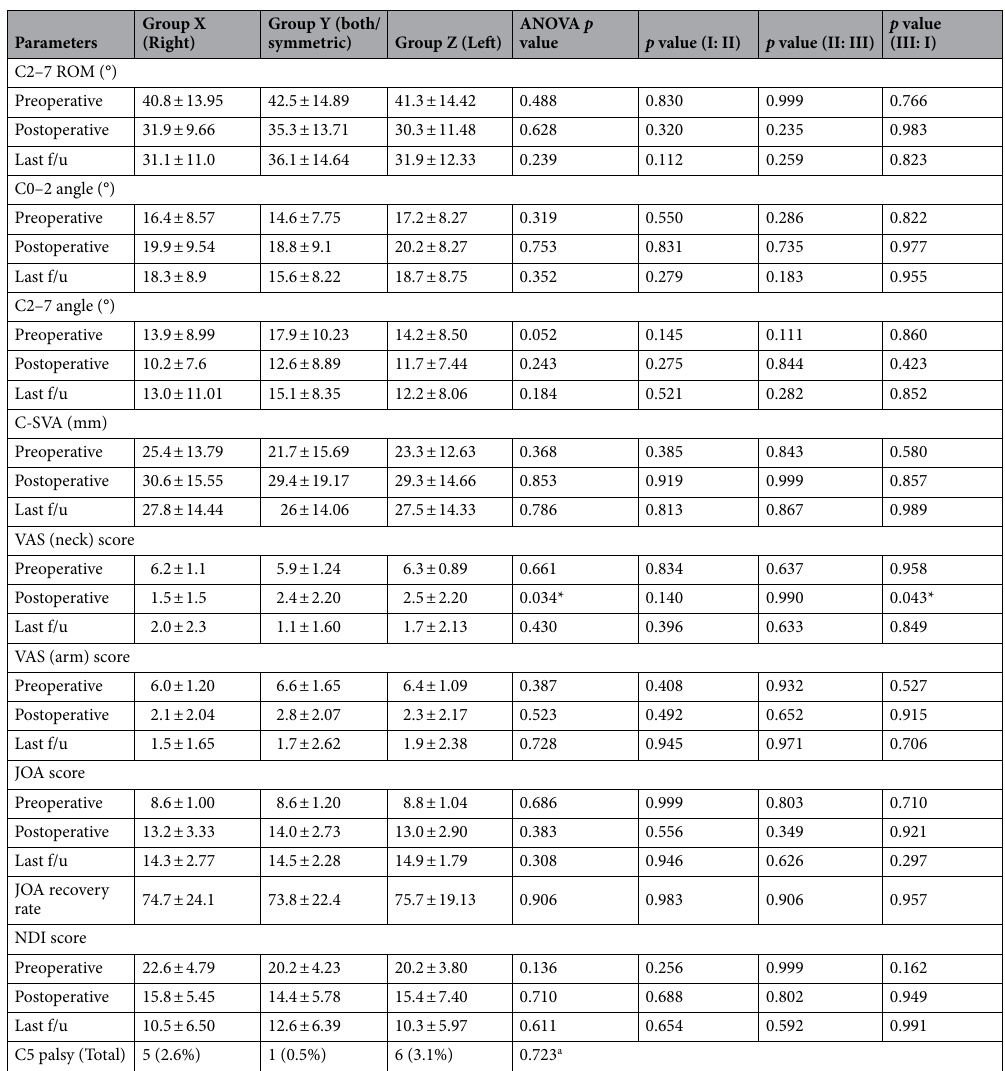
Table 6. Comparison of outcomes according to dominant radiculopathy symptom side. Significant are in value [bold]. C-SVA indicated cervical sagittal vertical axis; VAS visual analog scale; JOA Japanese orthopaedic association; NDI neck disability index. *Statistically significant ( p value < 0.05). a Chi-square